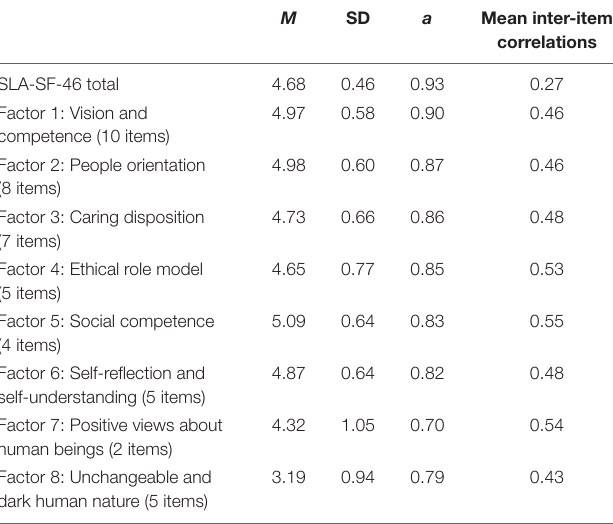
TABLE 6 | Descriptive statistics and reliability of SLA-SF-46.